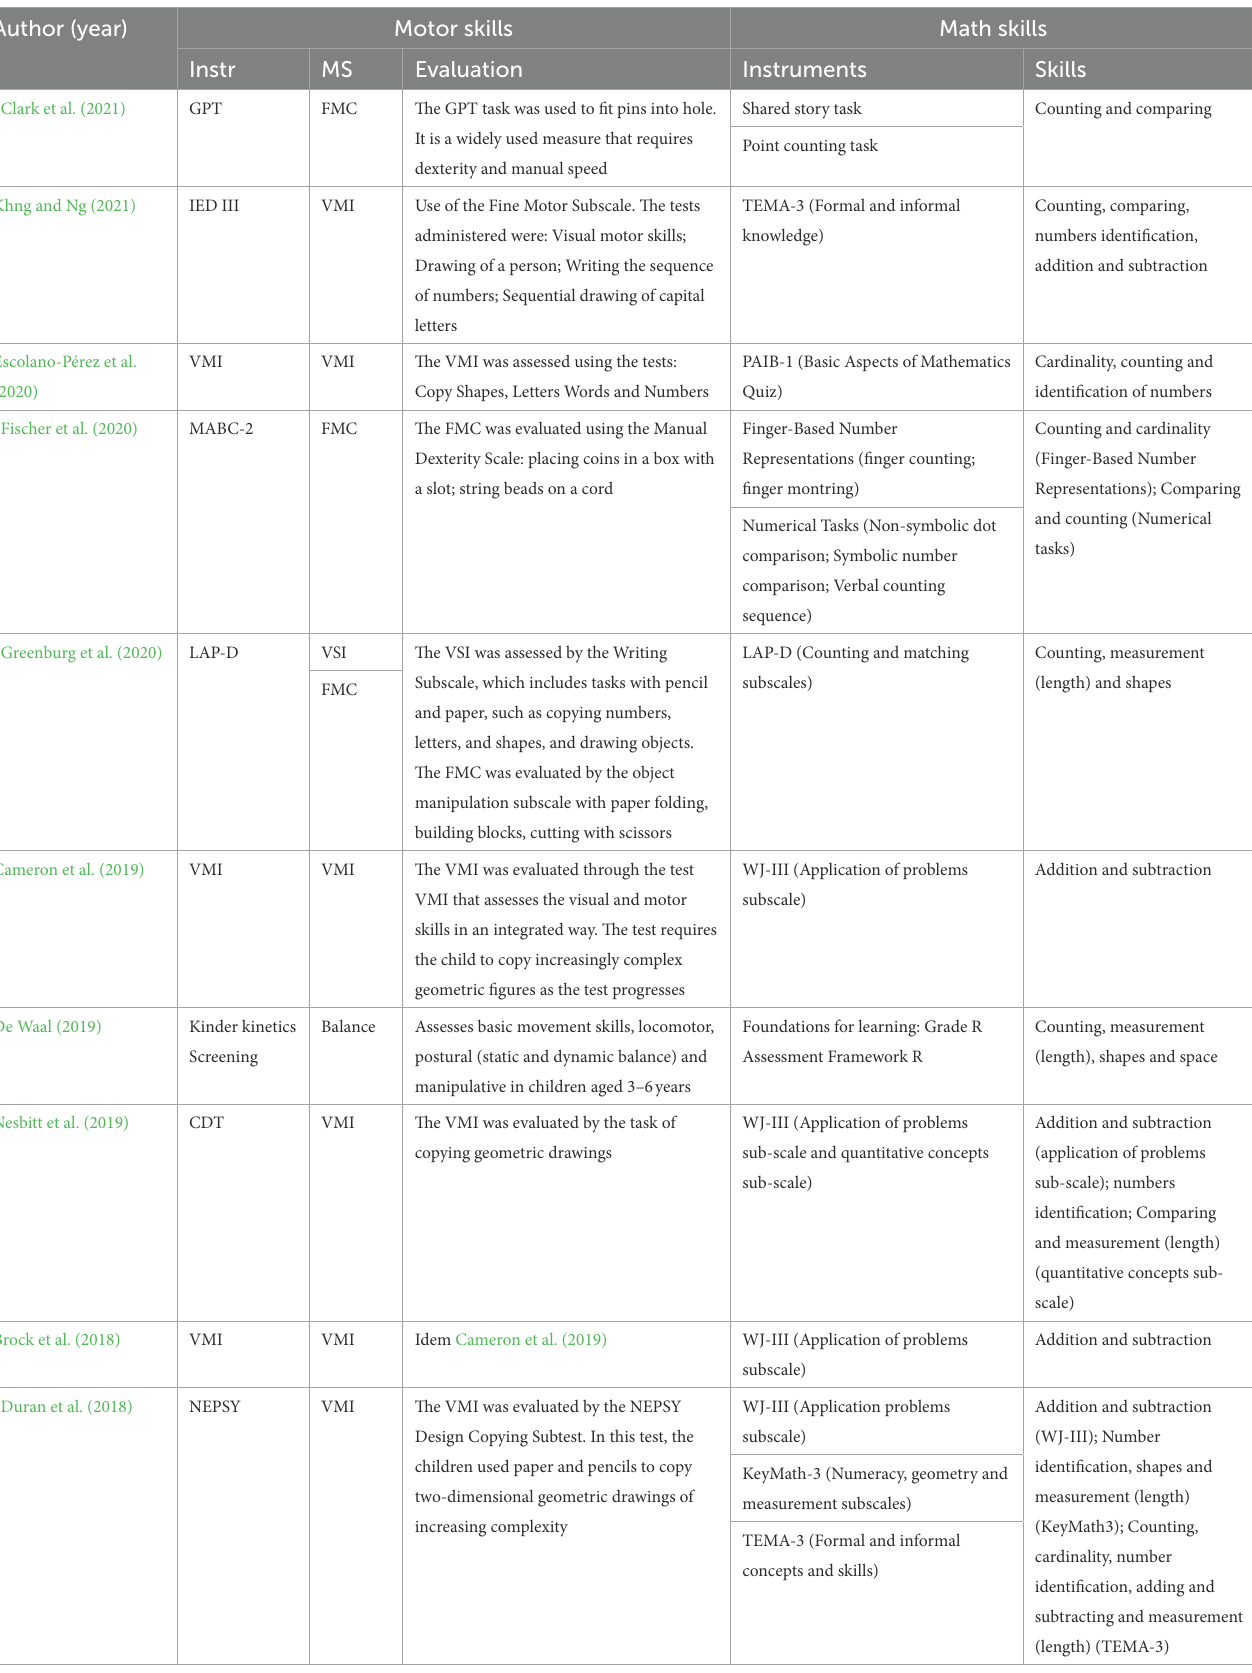
TABLE 4 Instruments used in the association between motor skills and math skills. Author